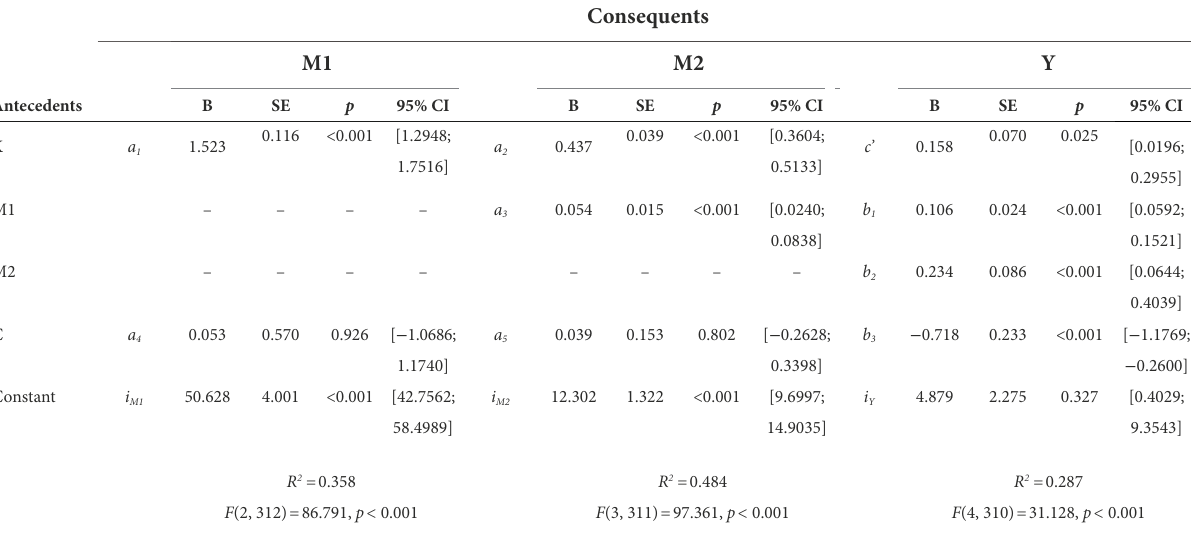
TABLE 3 Chained mediation model